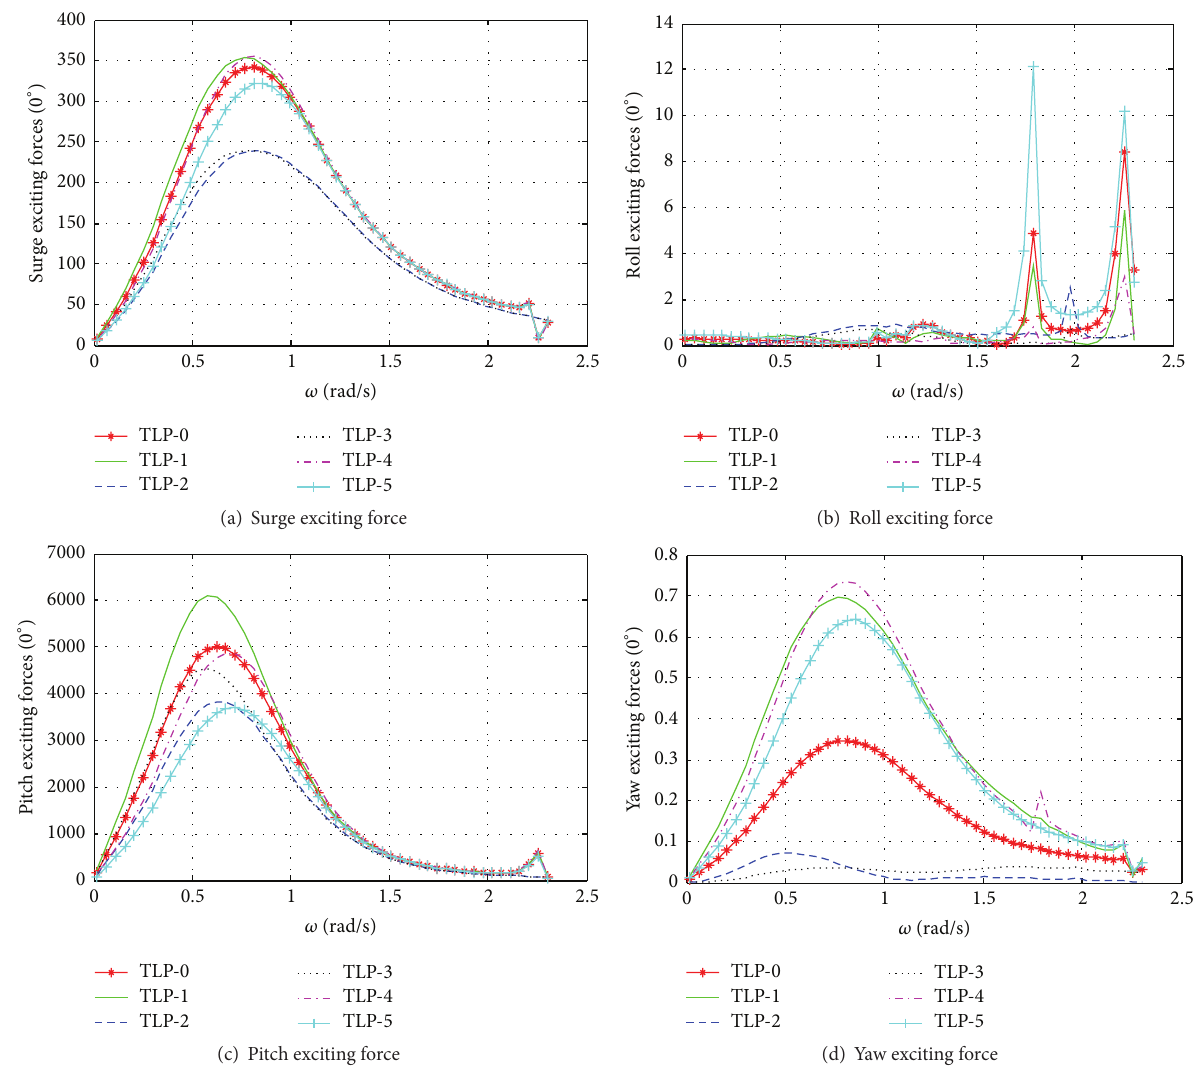
Figure 8: Exciting force